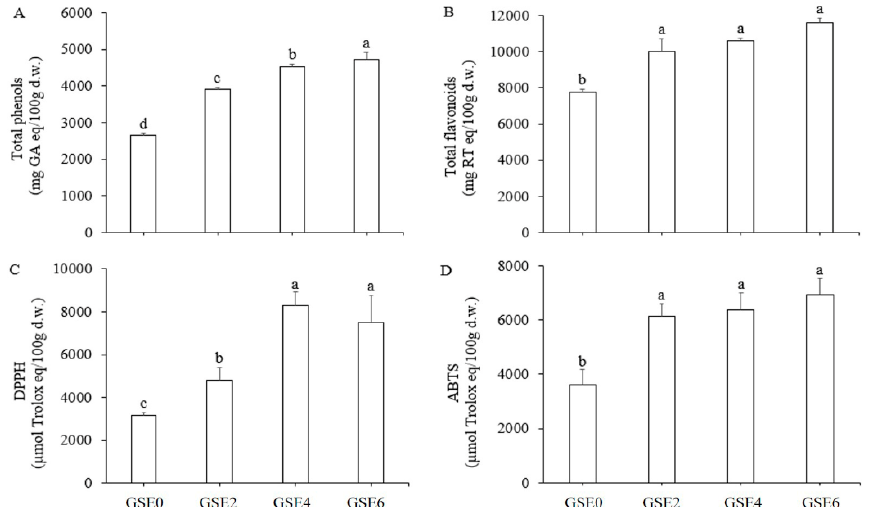
Figure 1. Changes in total phenols, total flavonoids, and the activities of two antioxidants in ginseng shoot extracts (GSEs) with steaming time. Gallic acid was used as the positive control for assays of total phenols ( A ), while rutin was used for total flavonoids ( B ). Trolox was used as the standard for 2,2 ′ -diphenyl-1-picrylhydrazyl (DPPH•)( C ) and 2,2 ′ -azobis-(3-ethylbenzothiazoline-6-sulfonic acid) (ABTS• + ) ( D ) scavenging activity assays. Absorbance was determined at 765 nm for total phenols, 410 nm for total flavonoids, 517 nm for DPPH, and 734 nm for ABTS. The results are presented as mean ± standard deviation (SD) of three independent experiments ( n = 3). Total phenols and total flavonoids were expressed as µmol standards/100 g dry weight (d.w.), while DPPH• ( C ) and ABTS• + ( D ) were expressed as µmol trolox/100 g d.w. Different letters indicate significant differences at p < 0.05 based on Duncan’s multiple range test.